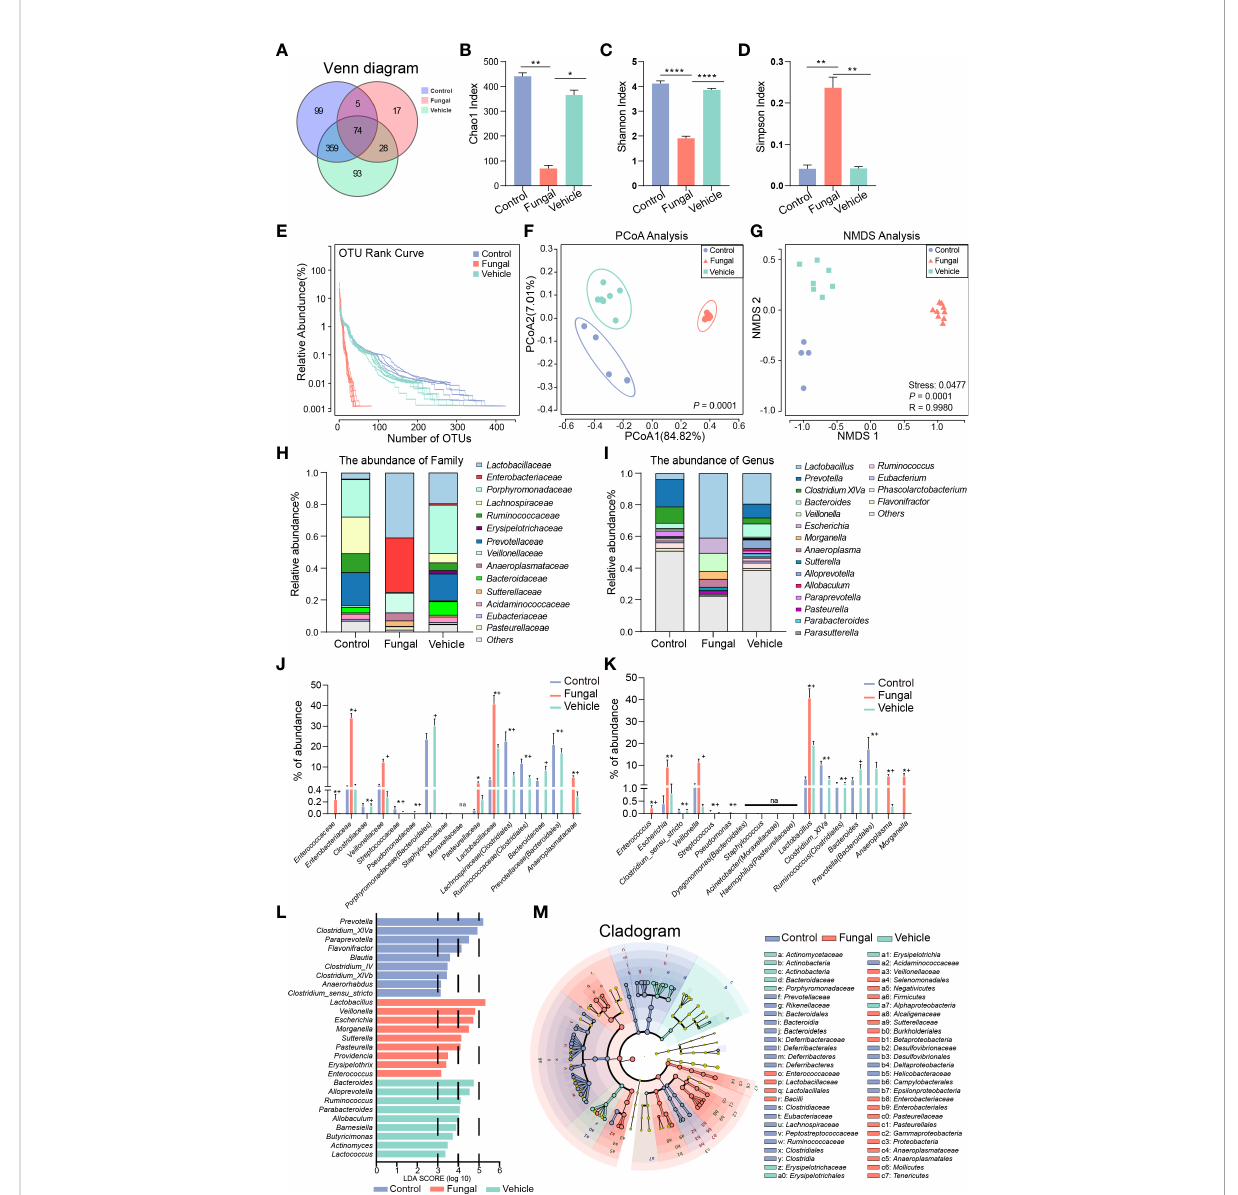
FIGURE 4 Comparison of intestinal microbial abundance and community composition among rats without any treatment (Control group), rats infected with fungi after antibiotic treatment (Fungal group) and rats inoculated with fungi only (Vehicle group). (A) A Venn diagram analysis shows the common and unique OTUs among the three groups. Three indexes of alpha diversity are displayed: (B) the Chao1 index, (C) the Shannon index, and (D) the Simpson index. The data are presented as the mean ± SEM. The P value was calculated with a Kruskal – Wallis test. *P < 0.05, **P < 0.01, ****P < 0.0001. (E) The RNK curve: the abscissa is sorted by sample OTUs, and the ordinate is OTU abundance. (F) Principal co-ordinate analysis (PCoA). PERMANOVA was used for comparison between groups. (G) Nonmetric Multidimensional Scaling (NMDS); groups were compared using Anosim. The Stress represents the difference between the distance of a point in two-dimensional space and that in multi- dimensional space. Stress < 0.05 is a perfect representation. Relative proportions of sequence read at the family (H) and genus (I) levels assigned to different bacteria. The microbiome abundance was less than 0.5% in all samples, and the unannotated microbiomes were all merged into Others. Comparison of relative abundance of bacteria at the family (J) and genus (K) levels. The results are presented as mean ± SEM, and the P value was calculated with a Kruskal – Wallis test. *P < 0.05 vs Control, #P < 0.05 vs Control, +P < 0.05 vs Fungal. (L) Differential enrichment of intestinal microbiota of rats in each group at the genus level according to linear discriminant analysis (LDA). Only taxa with LDA >3 at a P value <0.05 were considered signi fi cantly enriched. (M) Cladogram shows the community composition of the gut microbiota in rats based on LEfSe